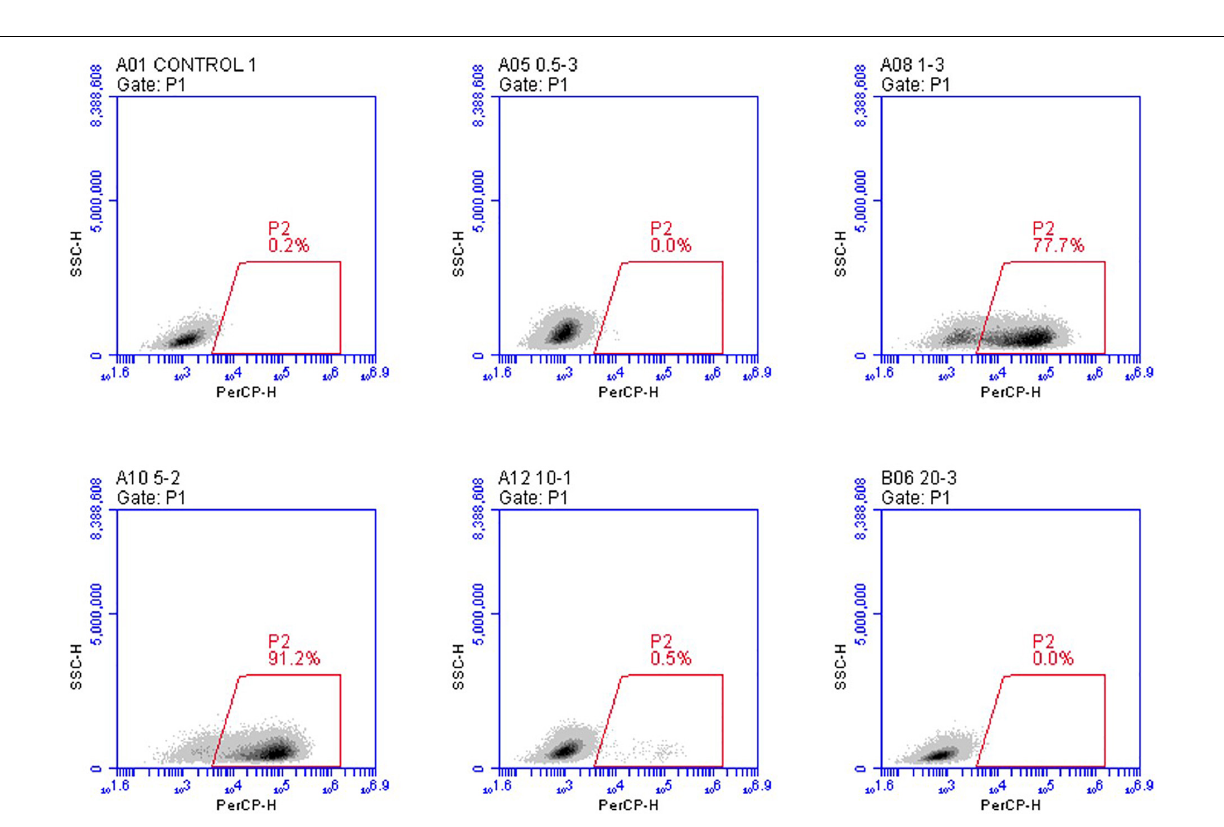
Frontiers in Microbiology |